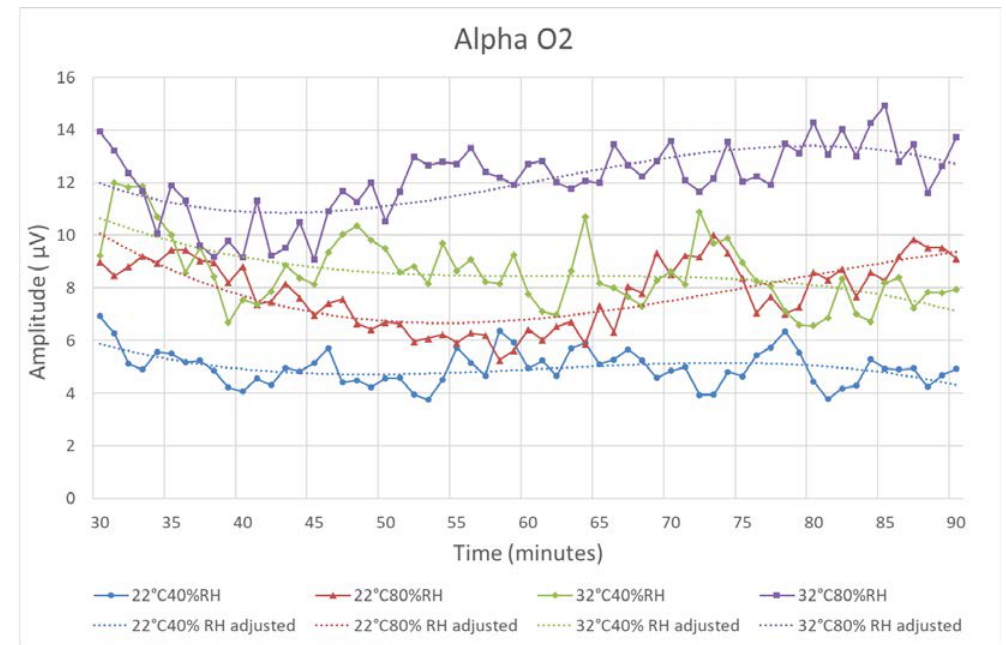
Figure 6. Mean values of Alpha O2 waves from the 15 volunteers at different